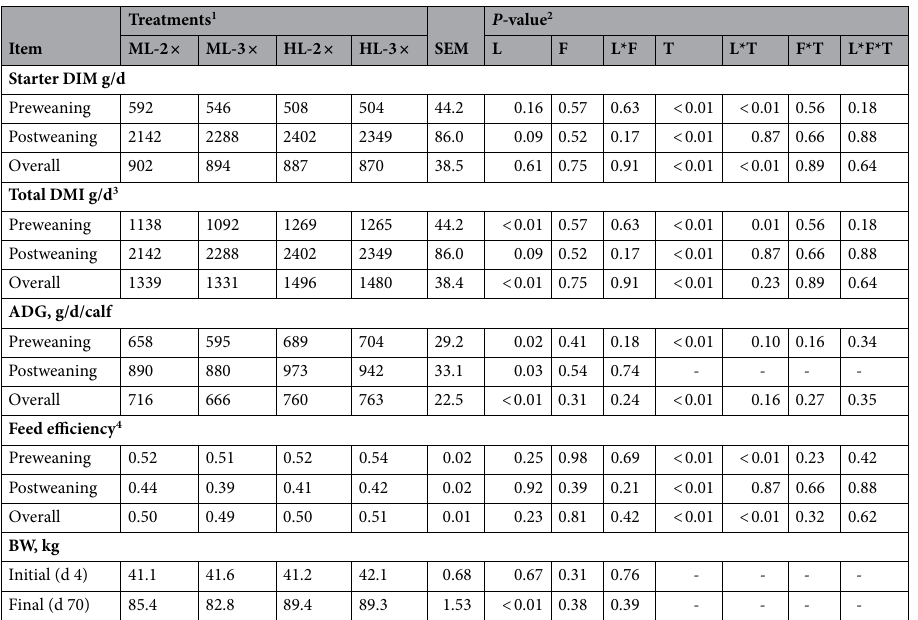
Table 2. Effects of milk feeding level (medium vs. high) and milk feeding frequency (2 vs. 3) on starter intake, total DMI, ADG, feed efficiency of dairy calves during preweaning, postweaning, and overall (n = 12